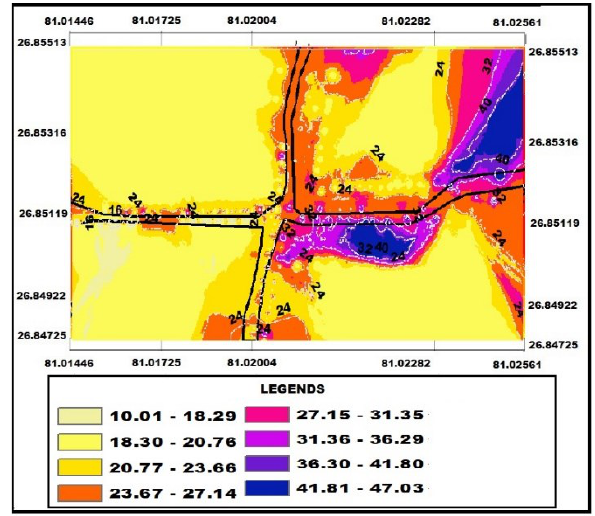
Figure 9. Noise level map of Haniman crossing showing the change in noise level of organized and unorganized traffic for morning time.